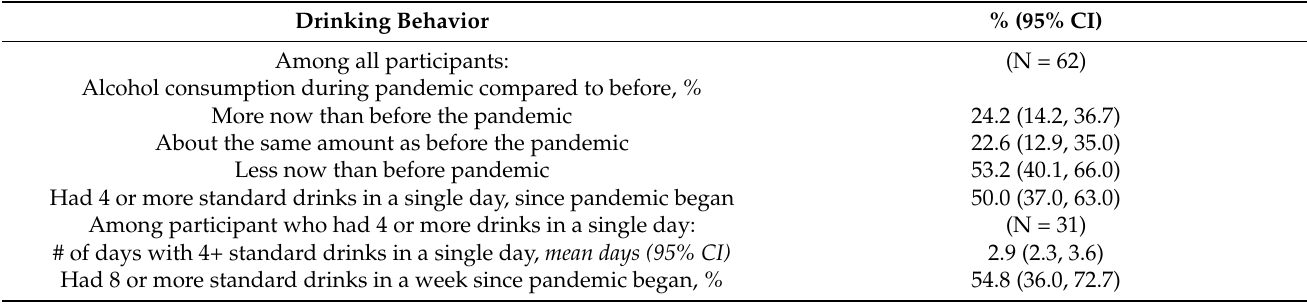
Table 2. Drinking behaviors during the pandemic in American Indian participants of the NCARE CHOICES study who completed a COVID-19 supplemental questionnaire.